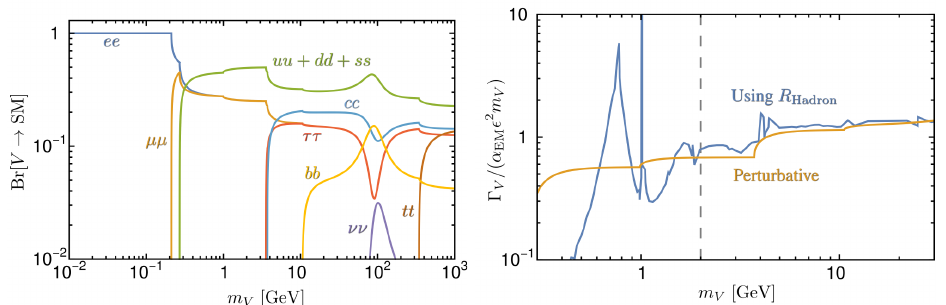
Figure 6: Left: dark photon branching fraction into various primary final states. A simple perturbative calculation is used with phase space factors for the quarks set to the lightest respective meson mass. The neutrinos are summed over all three flavours. Right: comparison of the experimentally determined hadronic width and = 2 GeV the agreement is suitably close the tree-level perturbative result. Above m V for our